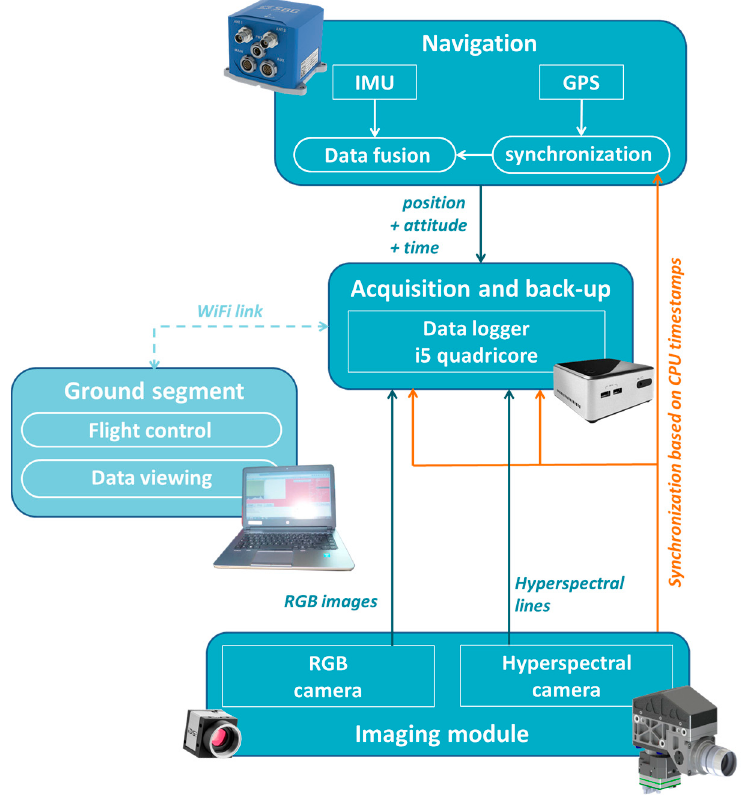
Figure 2. Diagram of the multi-sensor system.